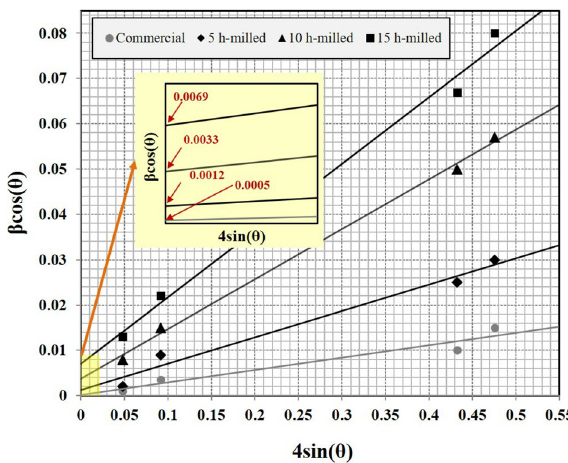
Figure 5. Williamson–Hall plots derived from the X-ray diffraction spectra of the commercial and ball-milled MCrAlY powders under different milling